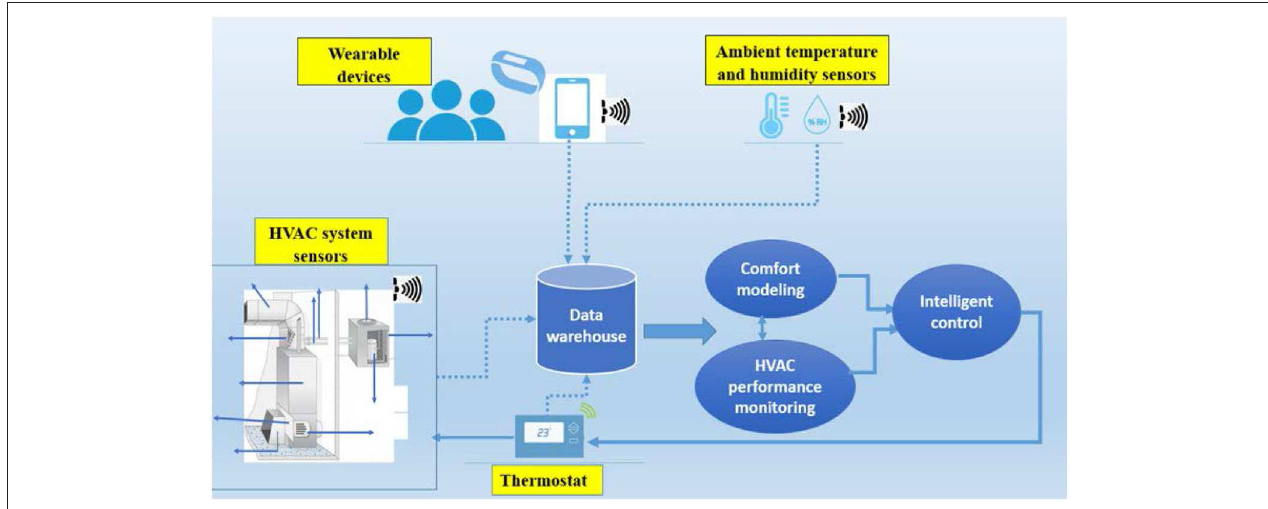
FIGURE 1 | A schematic for the comfort control